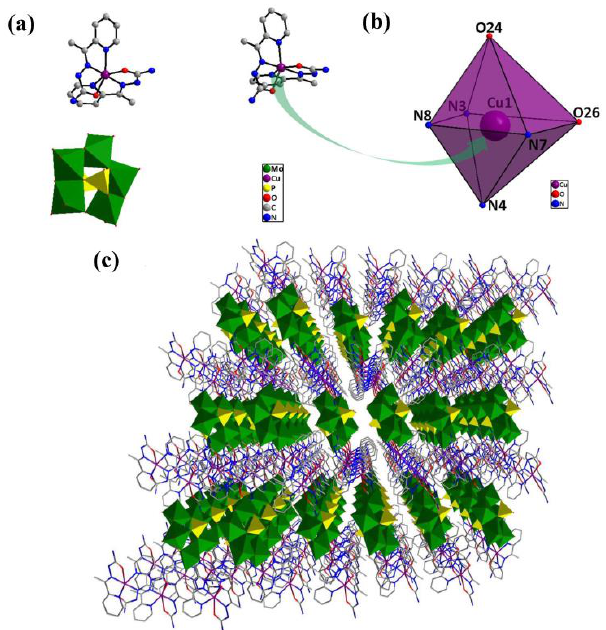
Figure 1. ( a ) Structure of compound 1 ; ( b ) structure of the six-coordinate distorted octahedral geometry around copper and ( c ) polyhedral/wire-stick representation of the 3D network along the a -axis.